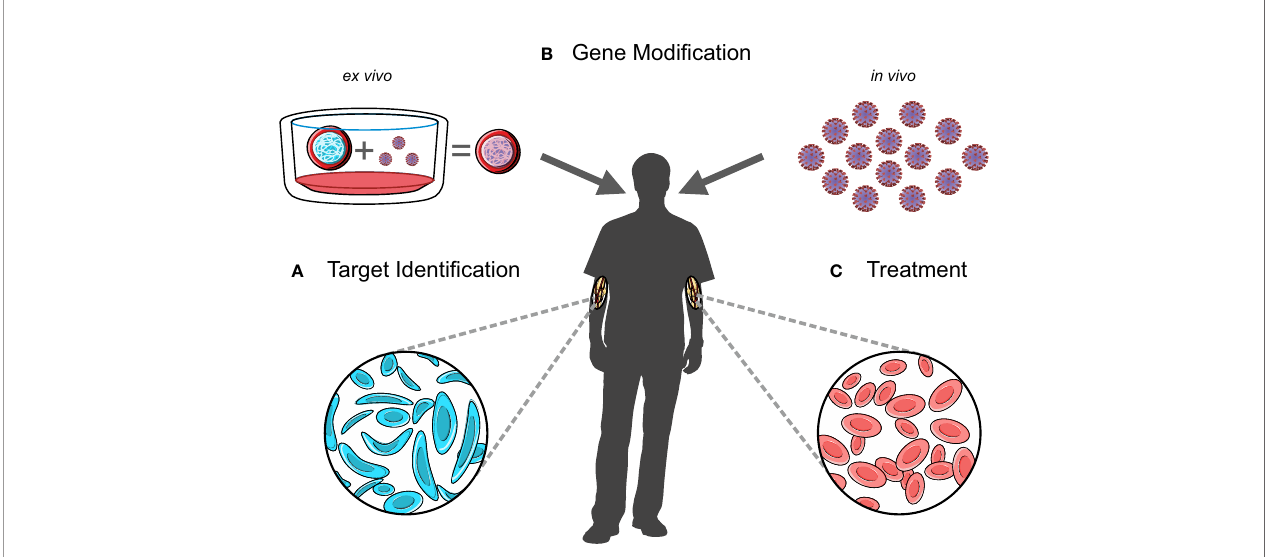
FIGURE 1 | A work fl ow for developing and administering gene therapy. Novel gene therapy approaches involve (A) the identi fi cation of therapeutic targets, (B) an ex vivo gene modi fi cation step to create a transduced drug product (left) or the production of an in vivo product (right), and (C) the infusion of these products into patients following myeloablative